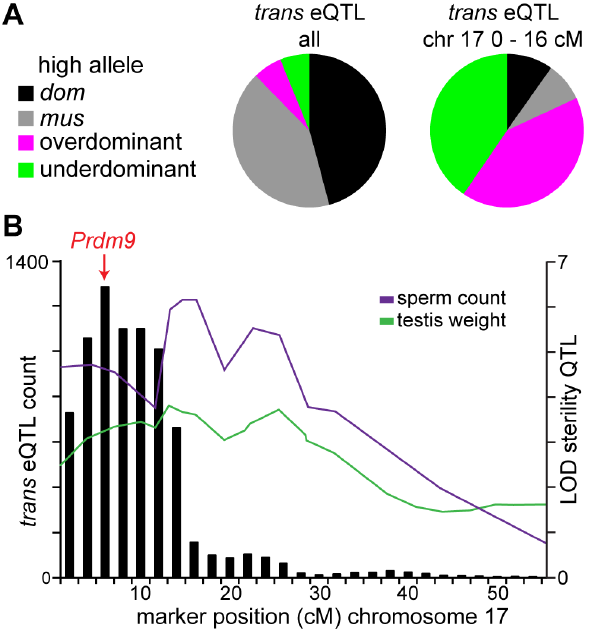
Figure 3. Chromosome 17 hotspot position and effects implicate Prdm9 . (A) Pie charts showing trans eQTL in the chromosome 17 hotspot are largely under- or over-dominant, in contrast to the pattern seen for trans eQTL overall. (B) Histogram of trans eQTL counts for 4 cM sliding window overlaid with LOD plots for coincident sperm count and testis weight